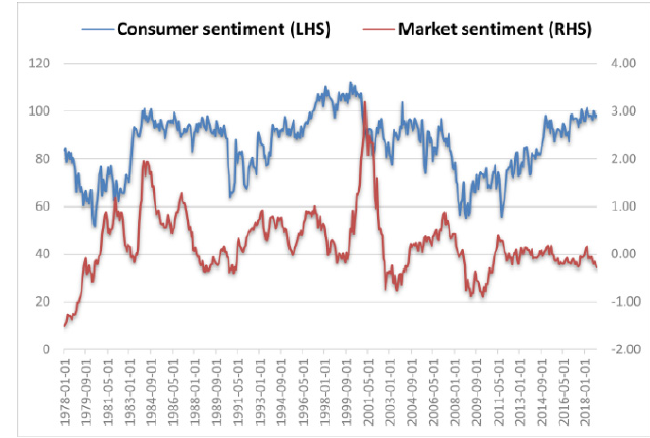
Figure 6. Changes in market sentiment and consumer sentiment